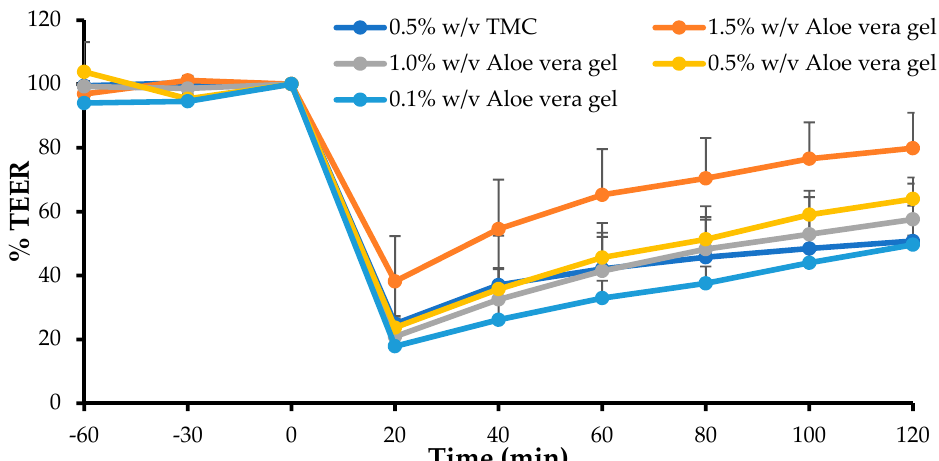
Figure 2. Percentage transepithelial electrical resistance (TEER) of the Caco-2 cell monolayers, after application of the A. vera gel, at different concentrations, and N -trimethyl chitosan chloride (TMC) (0.5% w / v , positive control), plotted as a function of time ( n = 3) (Error bars represent standard deviation (SD)).